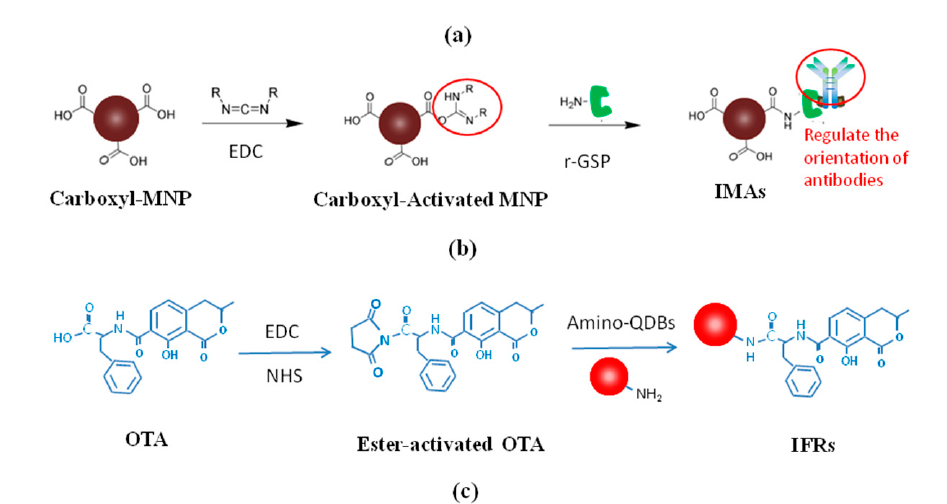
Figure 1. The scheme of the current experiment. ( a ) The scheme of the immuno-separated assay coupled with nano-affinity cleaning up for LC-confirmation. ( b ) The scheme of IMAs synthesis. ( c ) The scheme of IFRs synthesis. Notes of Figure 1a: ① Immuno-separation of OTA; ② Immuno- separation of IFRs, ③ Detection of fluorescence of remaining IFRs for Immuno-separated assay; ④ Elution of separated IMAs for LC-confirmation of OTA concentration.